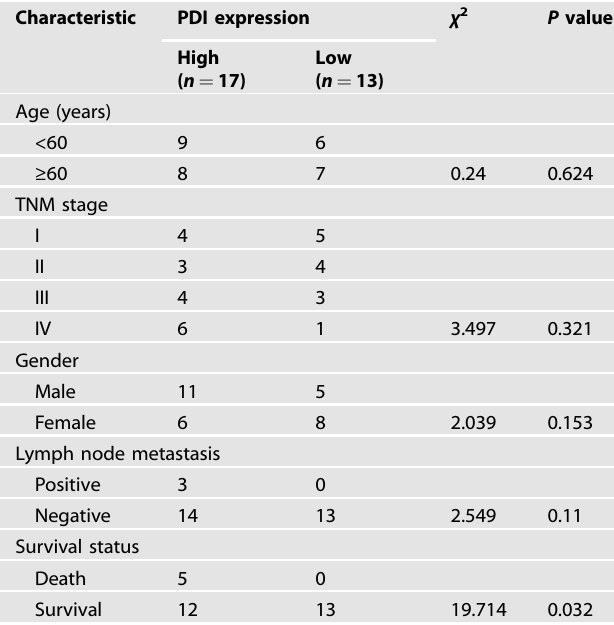
Table 1. Demographic and clinicopathological parameters of patients with hepatocellular carcinoma (data from 30 clinical